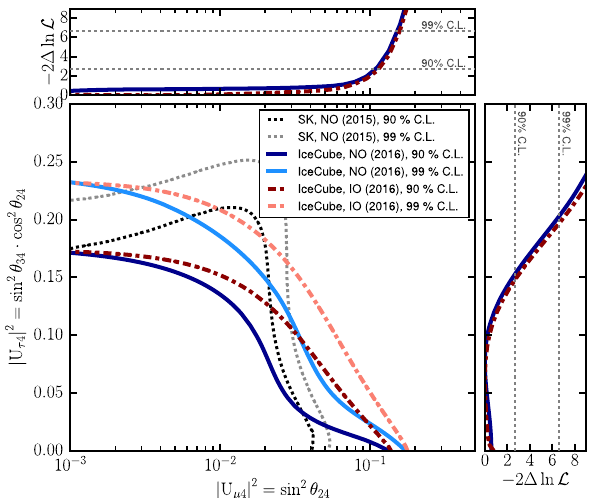
Fig. 22 The exclusion contours on the (sin 2 θ 24 , | U τ 4 | 2 ) plane at 90% and 99% CL (dark and light blue solid lines, respectively). The dash lines show results from the Super-Kamiokande [152]. Figure reprinted with permission from [129] (Copyright 2017